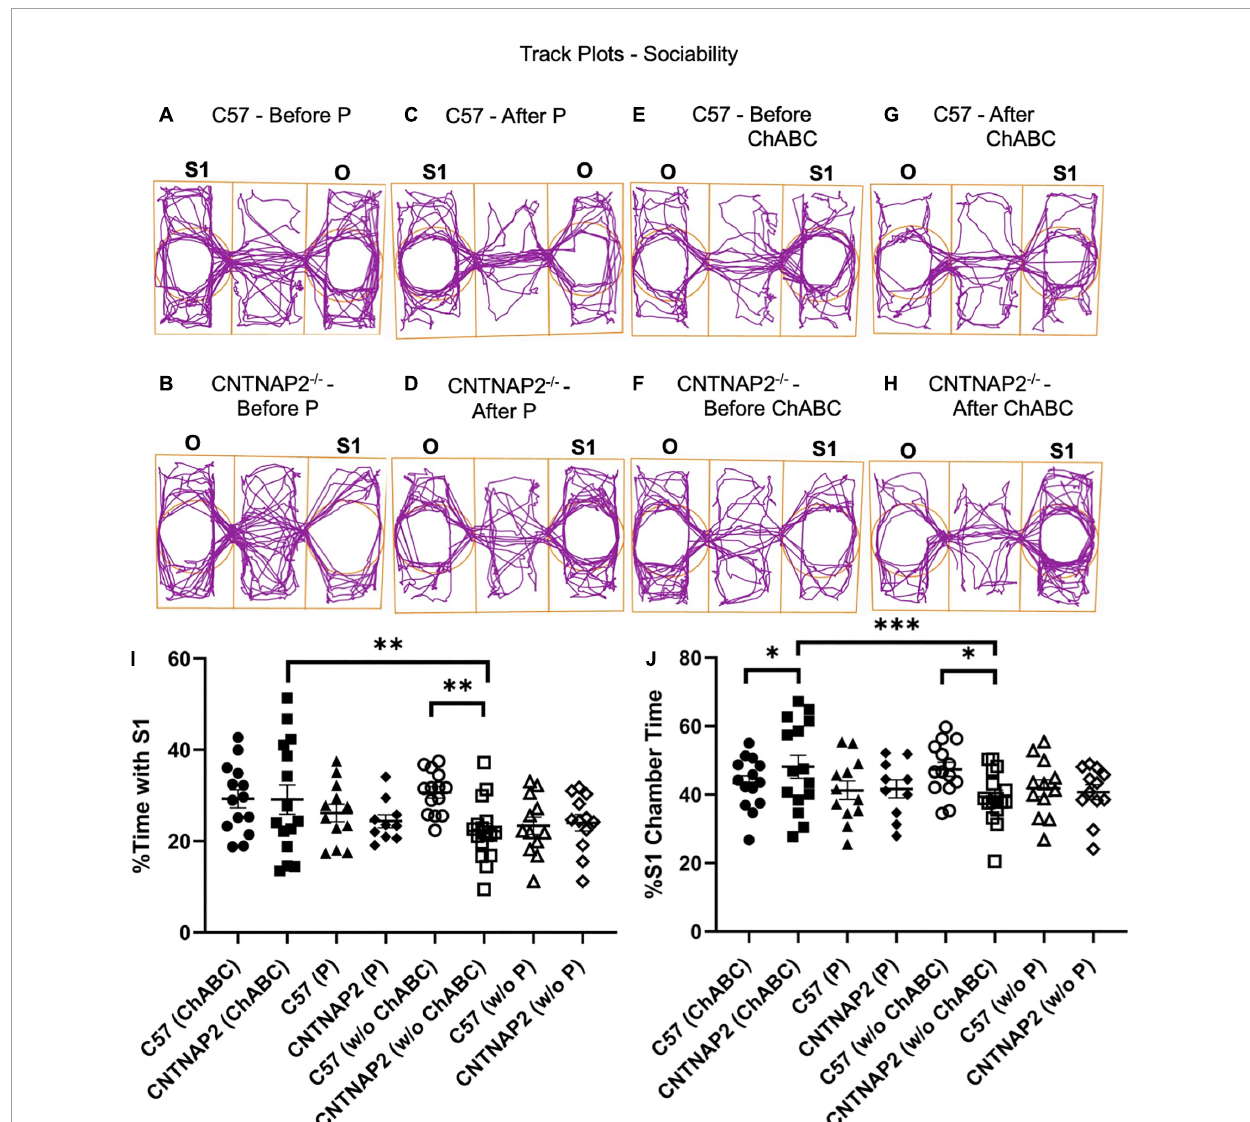
FIGURE4 Assessment of sociability in the three-chamber sociability test. (A–H) Track plot examples display the position of the animal’s center point for the total test duration before penicillinase injection (A,B) , after penicillinase injection (C,D) , before chondroitinase ABC injection (E,F) , and after chondroitinase ABC injection (G,H) in adult C57BL/6J and CNTNAP2 − / − mice. (I,J) Quantification of three-chamber sociability performance according to percentage time spent with stranger mice (I) and percentage time spent in chamber housing stranger mice (J) in adult C57BL/6J and CNTNAP2 − / − mice. C57BL/6J mice treated with chondroitinase ( n = 8 males; n = 6 females) and penicillinase ( n = 6 males; n = 6 females). CNTNAP2 − / − mice treated with chondroitinase ( n = 8 males; n = 7 females) and penicillinase ( n = 4 males; n = 6 females). Data expressed as mean ± SEM. Mixed ANOVA and Fisher LSD post-hoc comparisons were performed with 3-way interactions (I: F 1 , 50 . 2 = 5.02, p = 0.0295; J: F 1 , 50 . 4 = 4.65, p = 0.0359). Significance levels ( ∗ , ∗∗ , ∗∗∗∗ ) are as noted in the